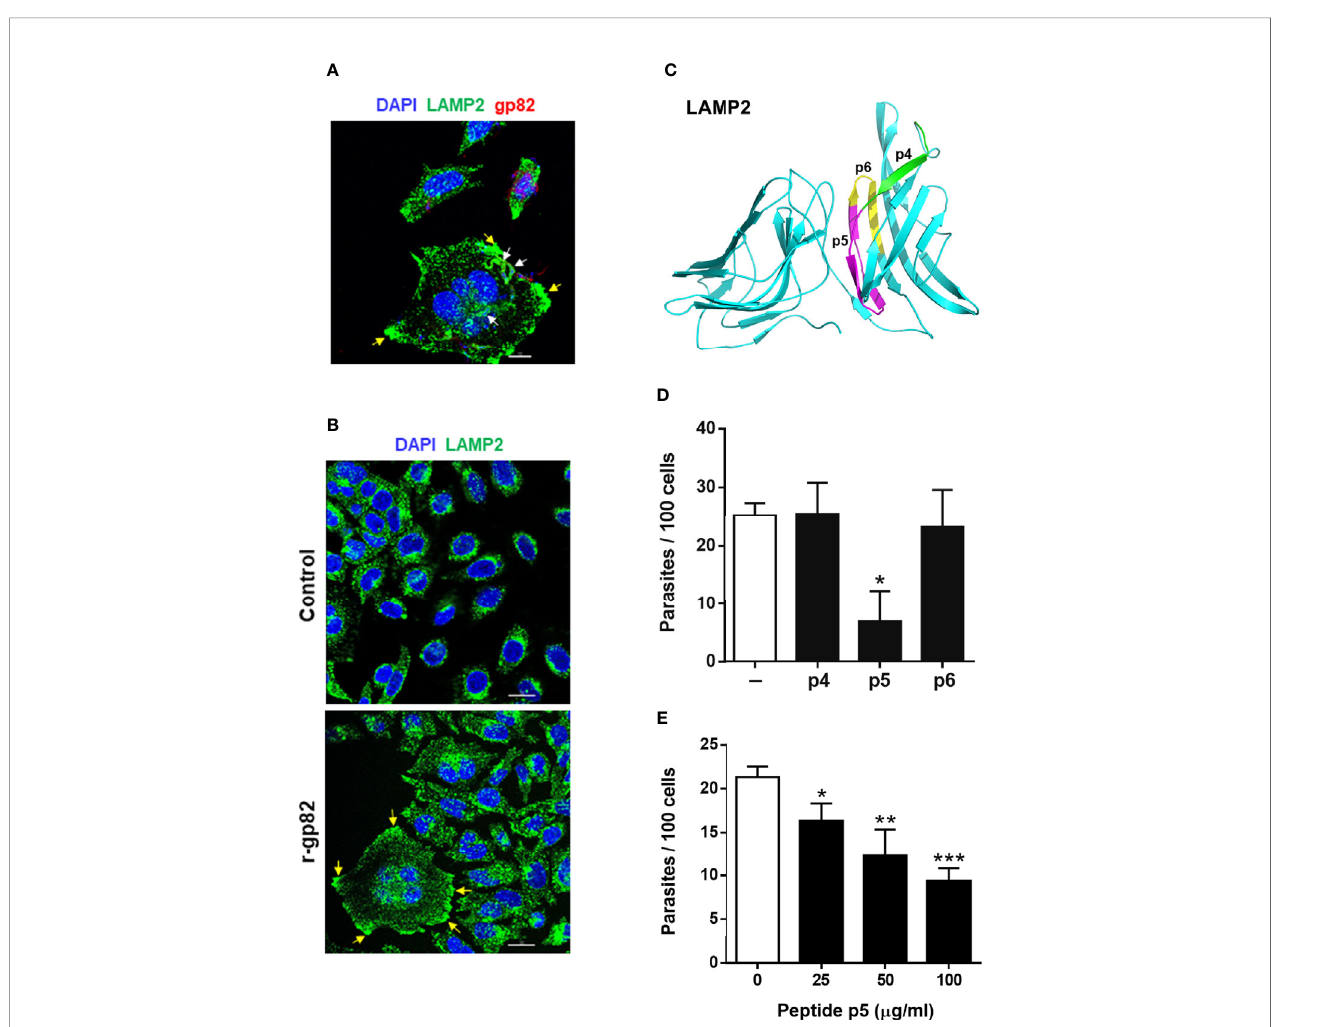
FIGURE 3 | Inhibition of gp82-mediated MT invasion of host cells by peptide p5. (A) HeLa cells were incubated with MT for 30 min and then processed for confocal fl uorescence microscopy to visualize lysosomes (green), nucleus (blue), and adherent parasites (red). Scale bar = 10 µm. Note the internalized MT with lysosome marker (white arrows) and lysosome accumulation at the cell edges (yellow arrows) in a multinucleated large cell. (B) HeLa cells were incubated for 30 min in absence or in the presence of recombinant gp82 (r-gp82) and visualized by confocal microscopy. Scale bar = 20 µm Note the perinuclear localization of lysosomes in control cells, the lysosome spreading in cells incubated with r-gp82 and the accumulation at edges (yellow arrows) in a multinucleated cell. (C) The 3D model of LAMP2, highlighting the peptide p5 sequence (magenta), the sequences of p4 (green) and p6 (yellow) that do not overlap with p5. (D) HeLa cells were incubated for 1 h with MT in absence or in the presence of the indicated peptide, at 100 m g/ml, and processed for intracellular parasite quanti fi cation. Values are the means ± SD of four independent assays performed in duplicate. MT invasion was signi fi cantly reduced in the presence of peptide p5 (* P < 0.001). (E) HeLa cells were incubated for 1 h with MT in absence or in the presence of peptide p5 at the indicated concentrations, and the internalized parasites was quanti fi ed. Values are the means ± SD of three independent assays performed in duplicate. Inhibition of MT internalization by peptide p5 was signi fi cant at all concentrations (* P < 0.05, ** P < 0.01, *** P <